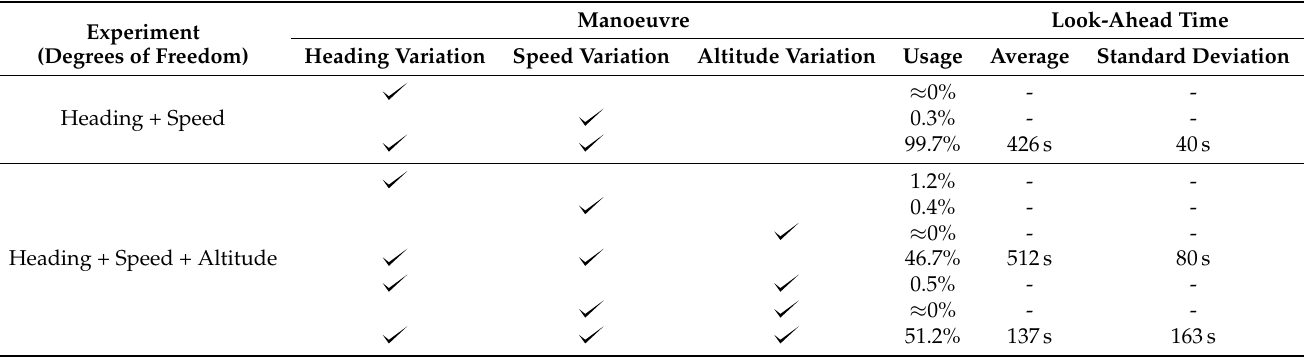
Table 5. Summary of the actions employed by the RL method in the training episodes.